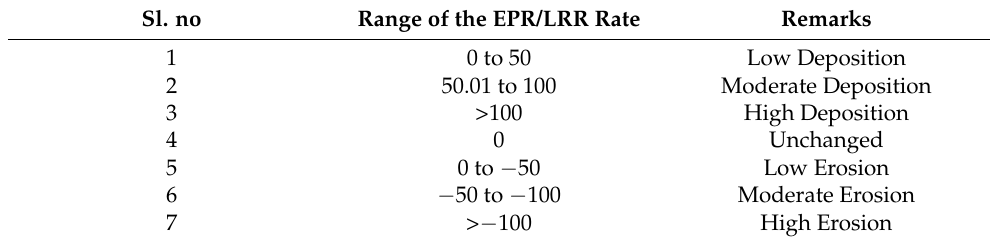
Table 2. Erosion and Deposition Grade according to the range of the EPR/LRR rate. Sl. no